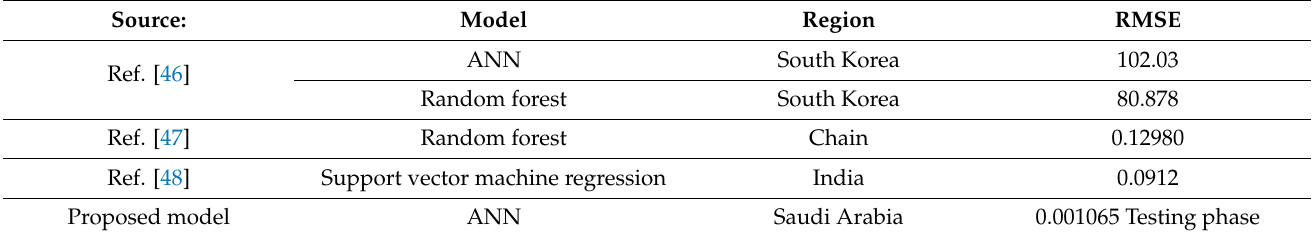
Table 5. Prediction results of the ANN model against existing